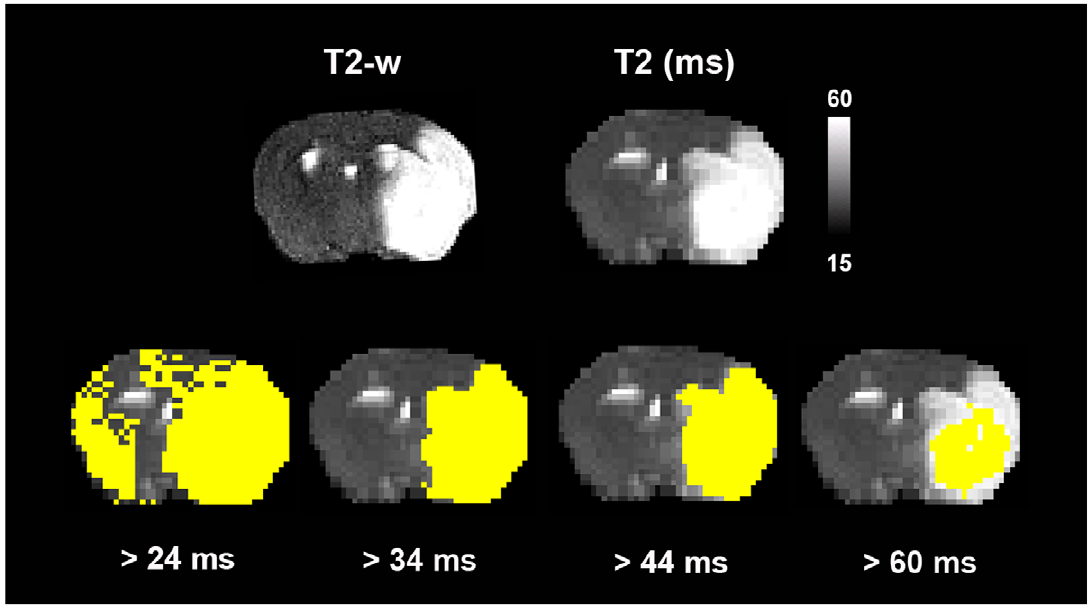
Figure 2. Results of automated stepwise binary segmentation of cerebral infarction. Different segmentation results are displayed for increasing quantitative T2 values. Accurate estimates of the extent of cerebral infarction as compared to high-resolution T2-w imaging (upper left) and histological stains with 2,3,5-triphenyltetrazolium chloride were achieved for a segmentation threshold of T2=34 ms. Delineation of infarction was performed on T2 relaxometric images at 24 h after the experimental procedure.